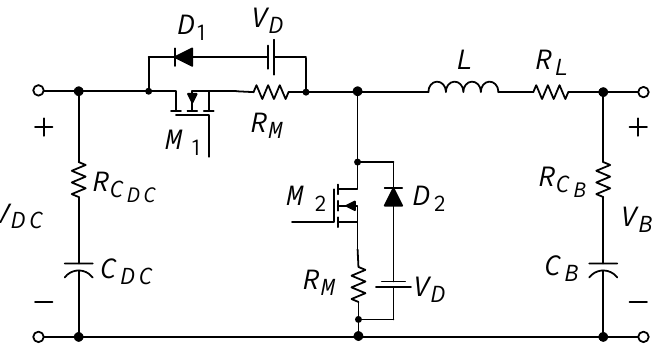
Figure 2. Circuit configuration of the battery charger/discharger.